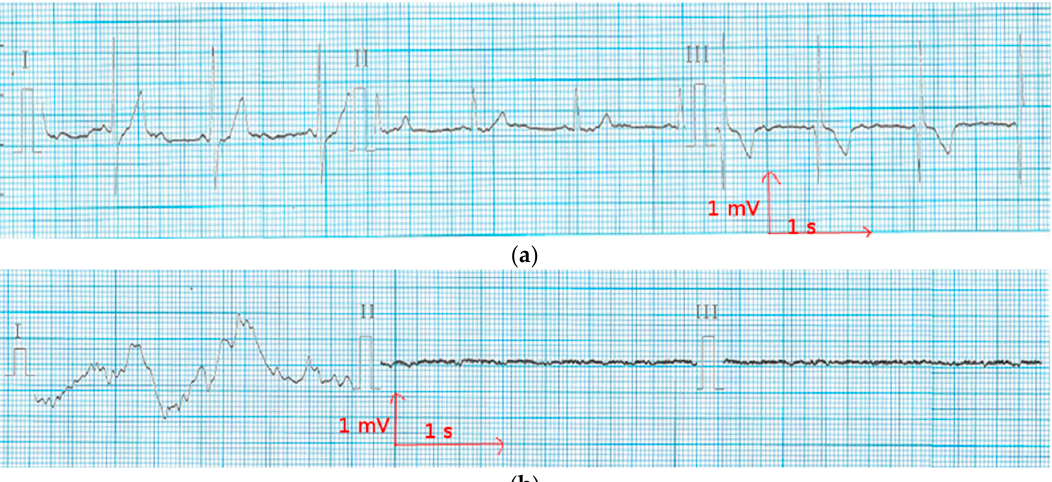
Figure 8. Electrocardiography from the polyamide electrodes after 50 washing cycles ( a ) at rest, ( b ) when walking, and ( c ) when climbing stairs.